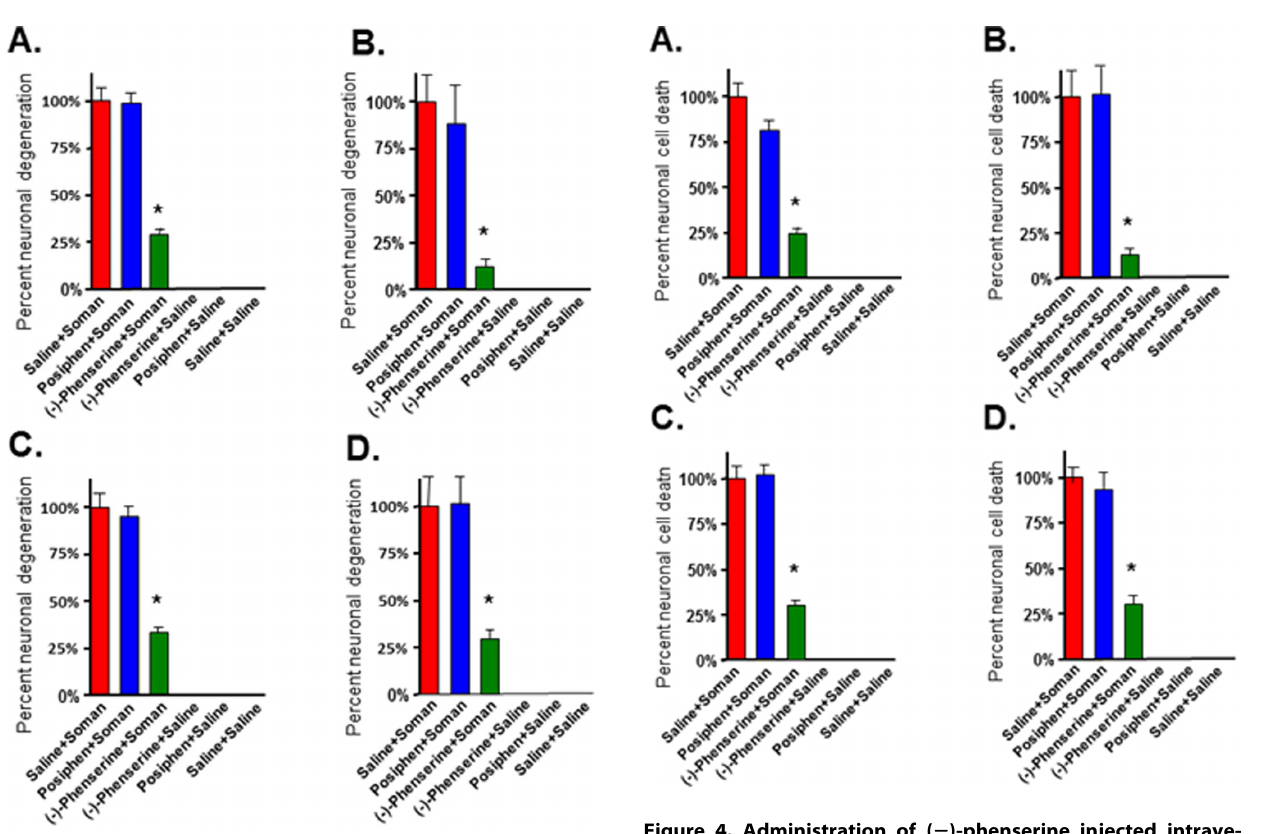
Figure 3. Administration of ( 2 )-phenserine 4 hr prior to soman protects against soman-induced neuronal cell death. Rats were pre-treated with ( 2 )-phenserine, posiphen or saline 4 hr prior to soman. Photographs were acquired from three representative fields in each brain region/animal. The bar represents the average percent neuronal cell death 6 SD in the pirform cortex (A), hippocampus (B), basolateral amygdala (C), cingulate cortex (D). The number of fluorescein-positive neurons was counted by an investigator that was blinded to the treatment. n=6/group. *p , 0.001 vs saline/soman by ANOVA + Tukey post hoc analysis.